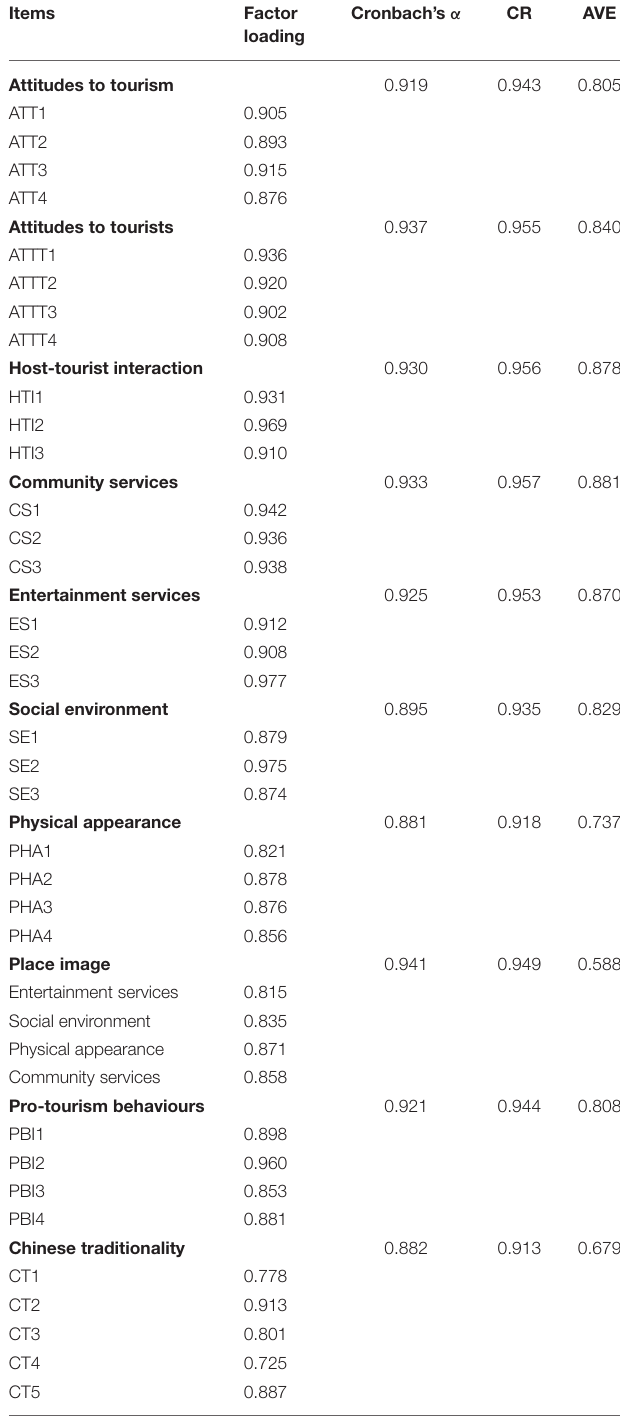
CR, composite reliability; AVE, average variance extracted.